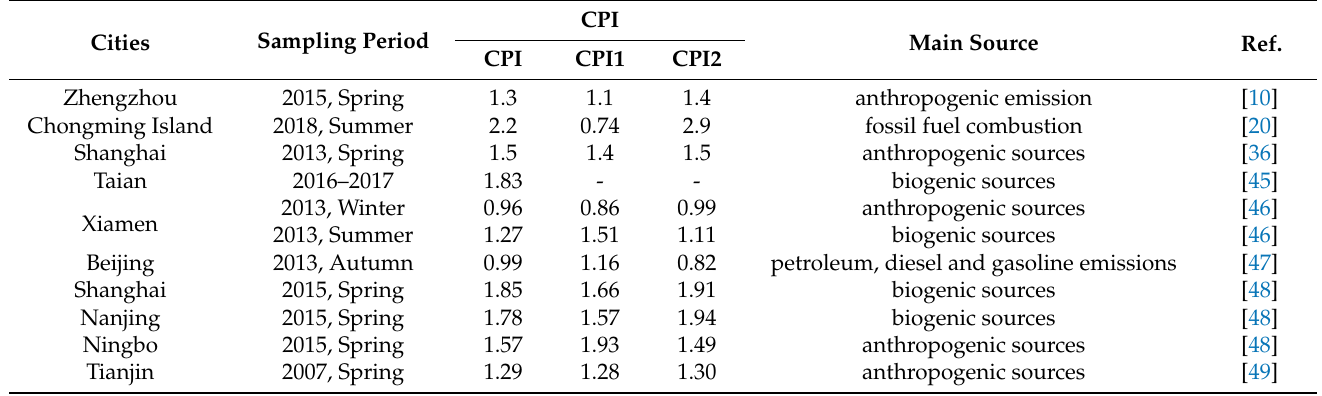
Table 3. Comparison of CPI in our findings with values reported in other cities in